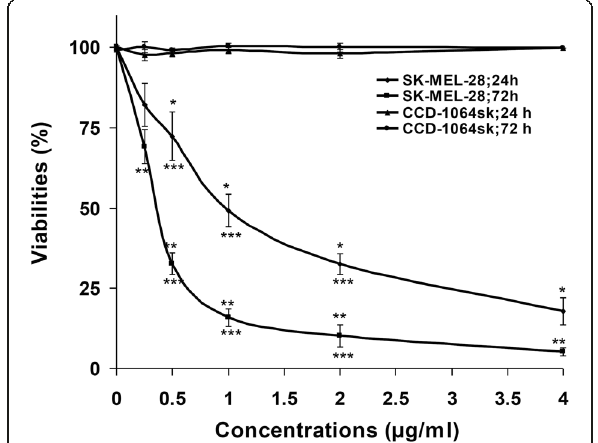
Fig. 2 Viability of SK-MEL-28 and CCD-1064sk cells treated with dssPLA 2 for 24 and 72 h. Data are expressed as means±SE of triplicates ( n =4). Treatment that significantly differed from untreated control for 24 and 72 h at p <0.05 are indicated as * and ** respectively. *** p <0.05 indicates the significant differences between 24- and 72-h treatment at the same concentration